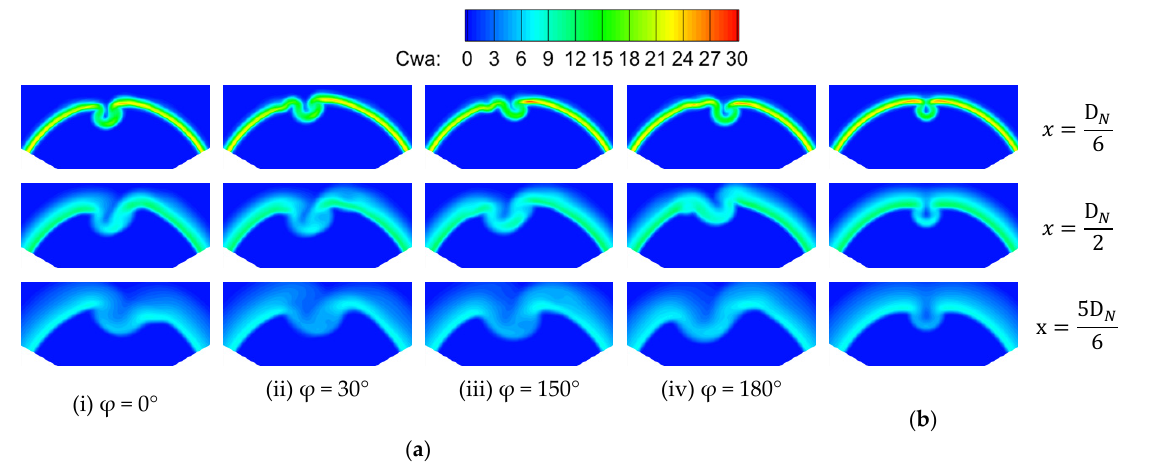
Figure 9. Spanwise vorticity for total pressure = 140 kPa: ( a ) instantaneous spanwise vorticity of fluidic oscillator at various moments; ( b ) time-averaged spanwise vorticity of air tab.